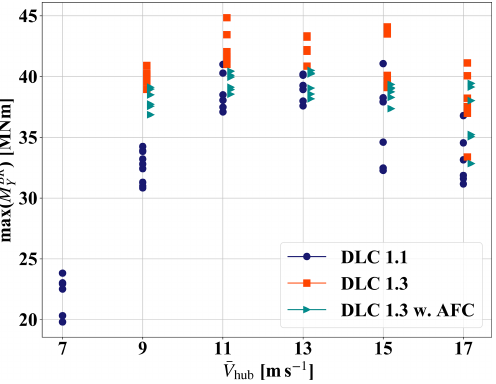
) vs. V hub for the individual simulations with Figure 9. max( M BR Y and without flap controller (AFC in the